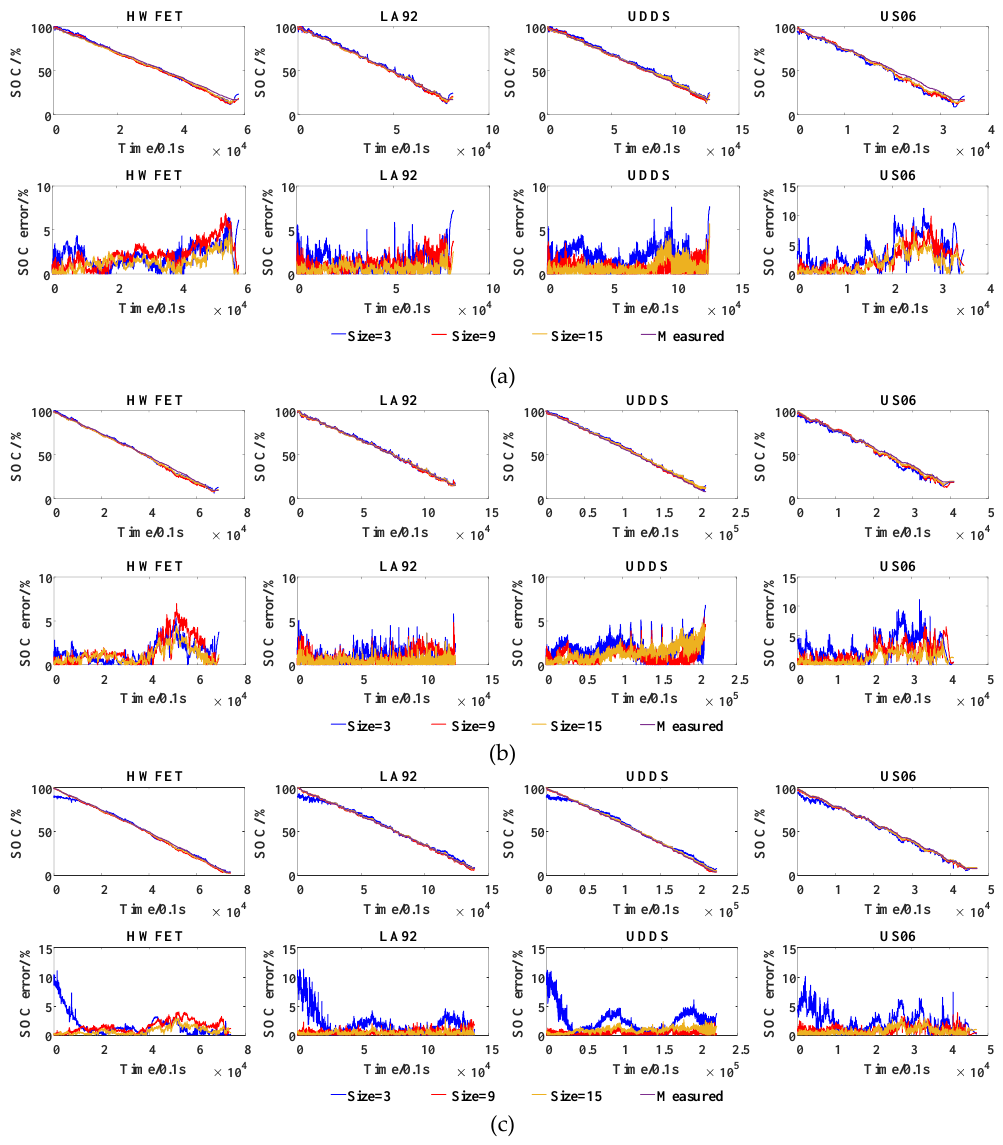
Figure 12. SOC estimation curves with different sizes of training data: ( a ) 0 °C; ( b ) 10 °C; ( c ) 25 °C.